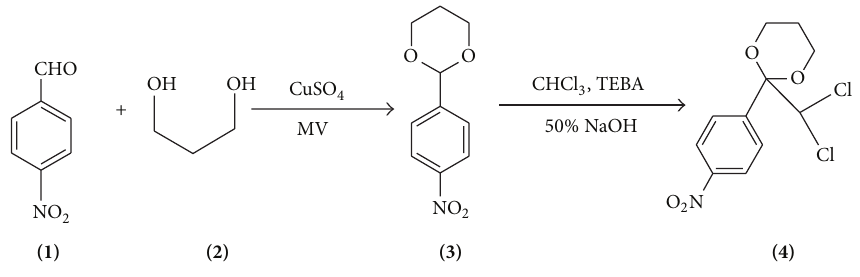
Scheme 1: Synthesis of the title compound 4 .